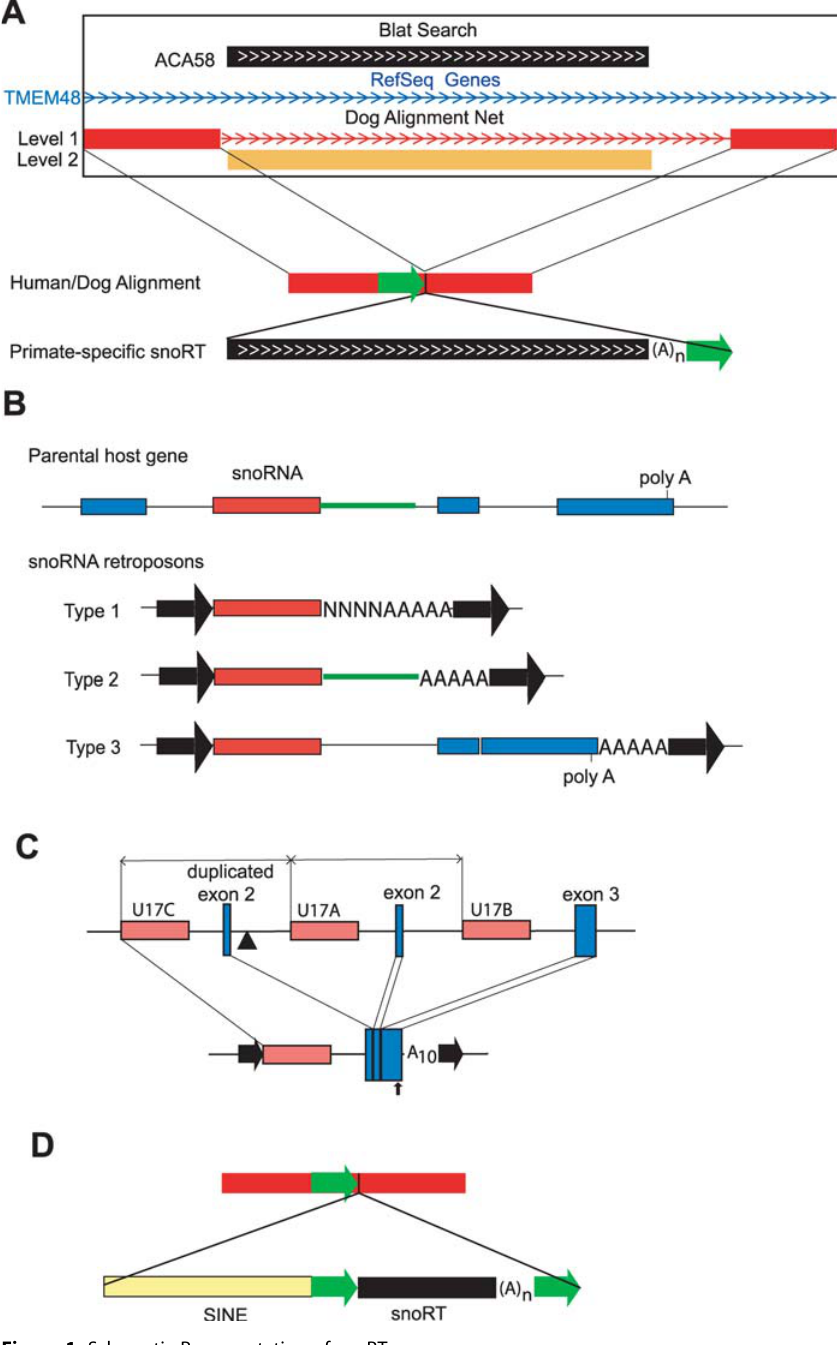
Figure 1. Schematic Representation of snoRTs (A) Analysis of a primate-specific snoRT. Upper panel: localization of the snoRT. A Blat search with the human ACA58 snoRNA sequence (hosted in the gene UBAPL2) localizes a close copy in the human TMEM48 gene. The Dog Alignment Net track of the UCSC Genome Browser shows two syntheny levels. Level 1 corresponds to the dog TMEM48 gene, but Level 2 corresponds to the dog ACA48 orthologue in the UBAPL2 gene. The Chimpanzee Alignment Net track shows complete syntheny with the human TMEM48 gene (unpublished data). Lower panel: characterization of the primate-specific ACA58 snoRT and determination of the insertion point. The ‘‘ view alignment details of parts of net within browser window ’’ tool of Dog Net track (Level 1) gives the alignment of the synthenic portions of the human and dog genomes (schematized on upper panel). Examination of the human sequence allows recognition of the polyA tail [(A)n] and the TSD (green arrows) and precise localization of the snoRT insertion point at one extremity of the TSD (lower panel). The detailed alignment is given in the Figure S1, section 13. (B) Description of the three types of snoRTs. The upper drawing shows the structure of the parental snoRNA HG. Blue and red boxes represent exons and the snoRNA sequence, respectively. The drawings below show the structures of Type 1–3 snoRTs. The partial snoRNA downstream intronic segment included in Type-2 retroposons is indicated by a green line. (C) Duplication of U17A in the cow U17 HG and structure of a cow snoRT. U17 sequences and exons are represented by red and blue rectangles, respectively (not to scale). The duplicated segment is indicated by horizontal arrows. A similar duplication is found in the armadillo U17 HG gene, with an additional 430-bp insertion indicated by the black arrowhead. The structure of a cow snoRT containing U17C and U17 HG exons is shown below. This PLoS Genetics |